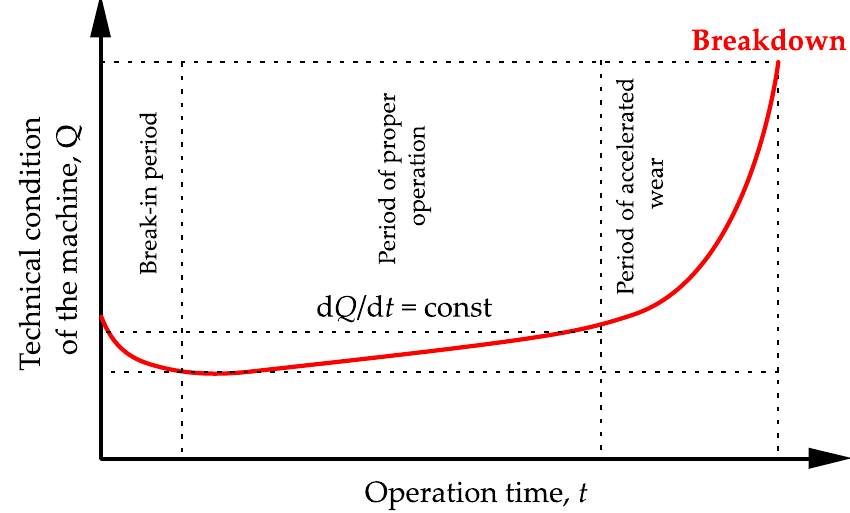
Figure 1. Graph of the technical condition of a machine during its operation.